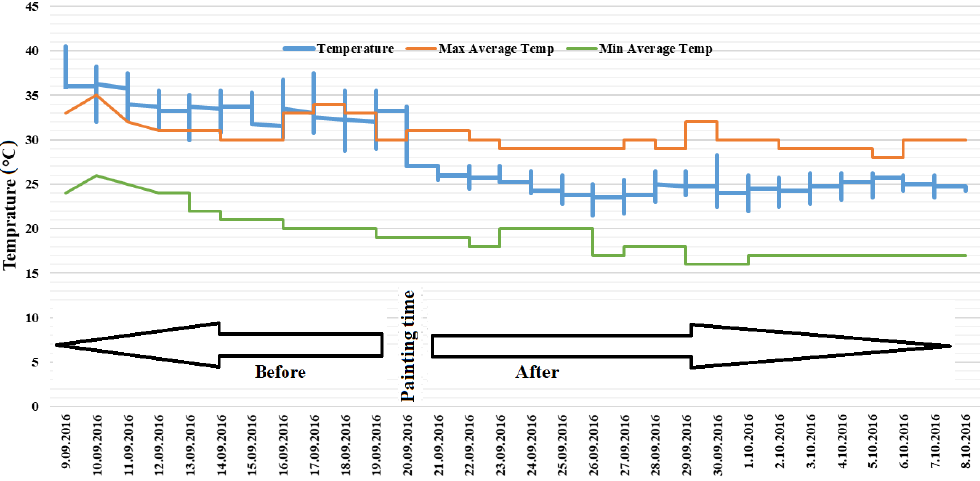
Figure 13. Measurement values of daily average and maximum/minimum temperatures for TR7.